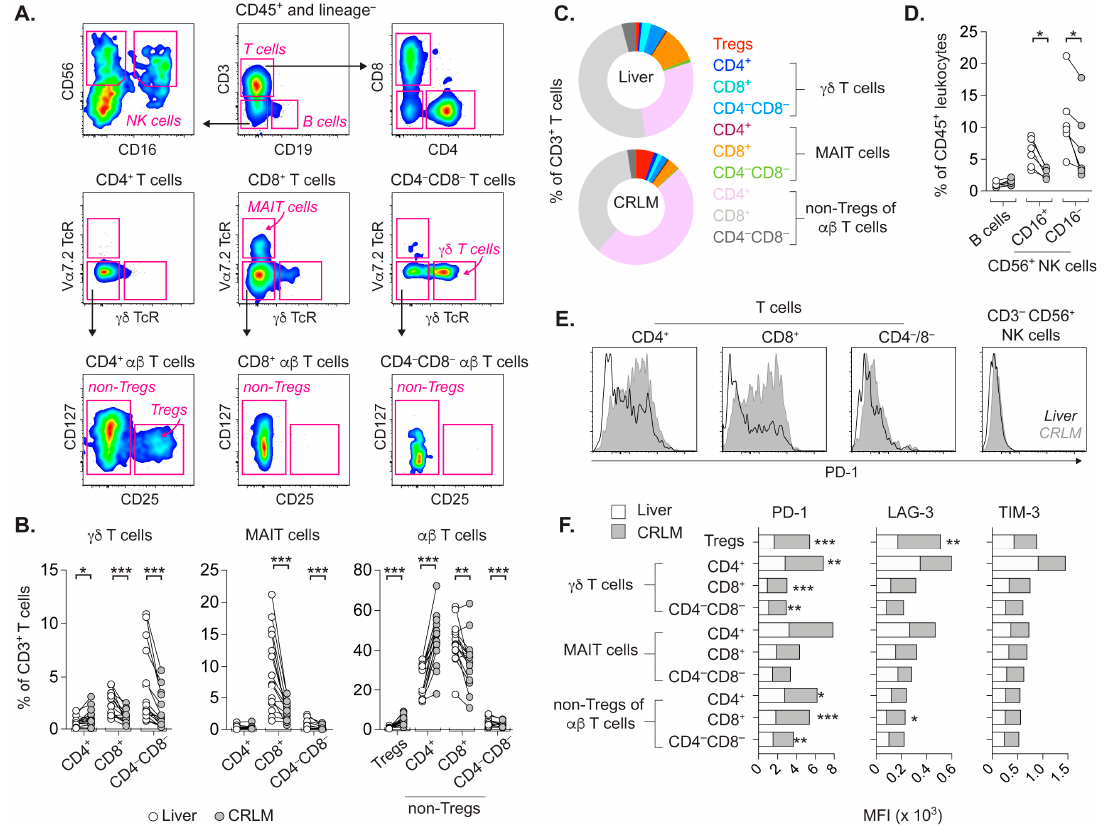
Figure 1. Characterization of lymphocytes in CRLM and adjacent liver tissue. ( A ) Gating strategy of lymphocyte subsets, as shown with single-cell suspension of CRLM. Viable, CD45+ and lineage (CD11c, CD15, CD123) − cells were divided into CD3+ T cells and CD19+ B cells. CD56+ NK cell subsets according to CD16 expression were gated from CD3 − CD19 − cells. CD3+ T cells were separated into CD4+, CD8+ or CD4 − CD8 − T cells. Unconventional V α 7.2 TcR+ MAIT cells were mainly among CD8+ T cells, and CD4 − CD8 − T cells contained γδ T cells expressing γδ TcR. Remaining T cells represent conventional αβ T cells, and CD127dim/ − CD25+ Tregs were gated from CD4+ αβ T cells. The CD25 − αβ T cells are referred to as non-Tregs. Compiled data on ex vivo percentages ( B ) and proportions ( C ) of indicated T cell subsets among CD3+ T cells in CRLM and adjacent liver. ( D ) Frequencies of B cells and NK cell subsets within CD45+ leukocytes. ( E ) Overlay of histograms on PD-1 staining intensity on T cells and NK cells in liver vs. CRLM. ( F ) Stacked bars show proportion of the mean fluorescence intensity (MFI) for the staining of PD-1, LAG-3 or TIM-3 on T cell subsets in CRLM and liver, respectively (* p <0.05, ** p <0.01, *** p <0.001, Wilcoxon test). The absence of γδ TcR and V α 7.2 TcR expression specified conventional T cells, referred to as αβ T cells. As previously reported, CD4+ αβ T cells contained CD127 dim/ − CD25+ Tregs were increased compared to the liver, but CD8+ or CD4 − CD8 − non-Tregs were regulatory T cells (Tregs) [24], and CD25 − T cells were denoted as